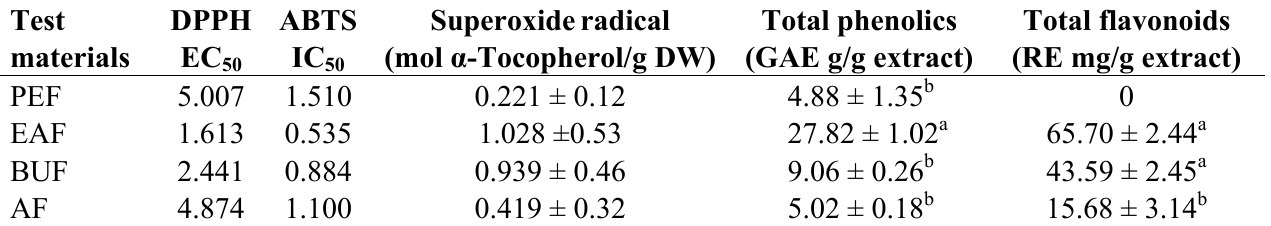
Table 2. The DPPH ˙ , ABTS + and Superoxide anion radical-scavenging capacities of the fractions from D. cambodiana and amounts of total phenolics and total flavonoids in fractions of D. cambodiana